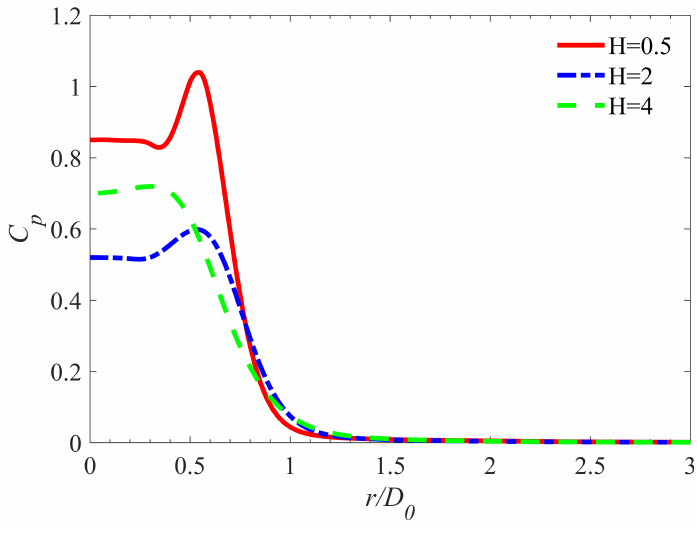
Figure 10. Radial pressure on the target surface for the straight nozzle.